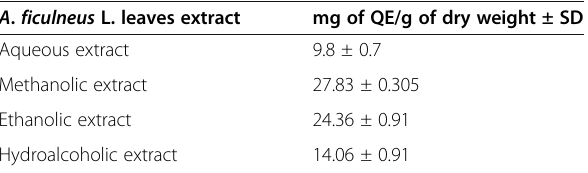
Table 1 Total flavonoid content in different A . ficulneus L. leaves extracts